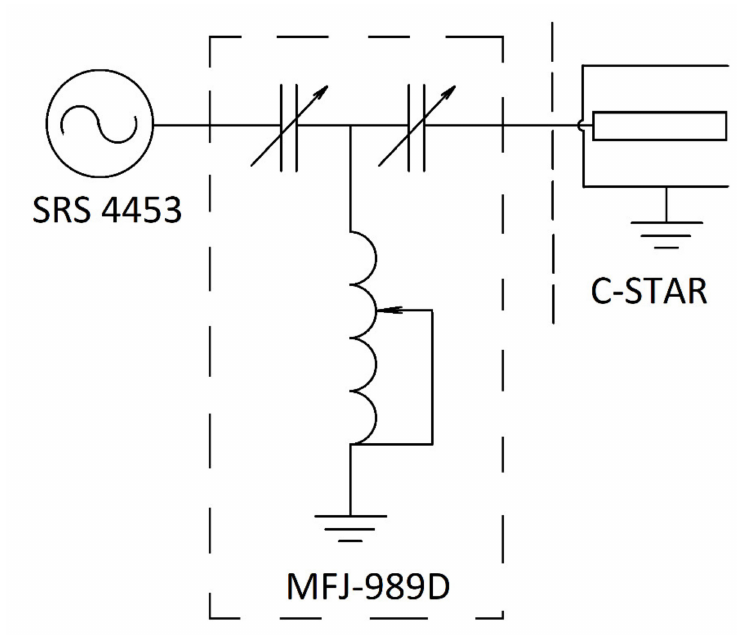
Figure 2. Electrical scheme of